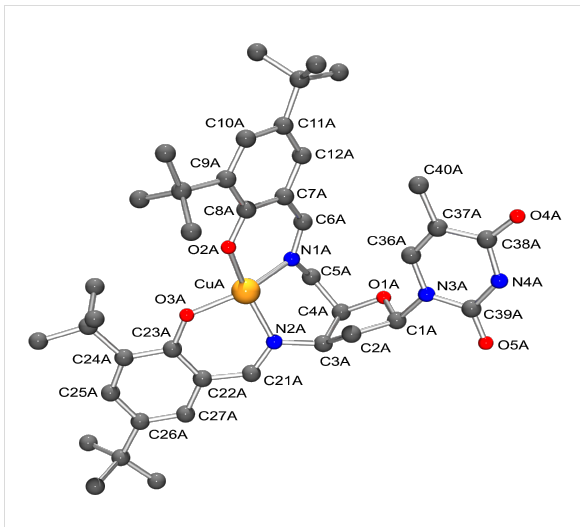
Figure 1: X-ray crystal structure of one of the molecules in 13 with used crystallographic numbering. H-atoms, the solvent molecule and the labels at the tert -butylgroups are omitted for clarity. Atomic displacement parameters are drawn at the 50% probability level.